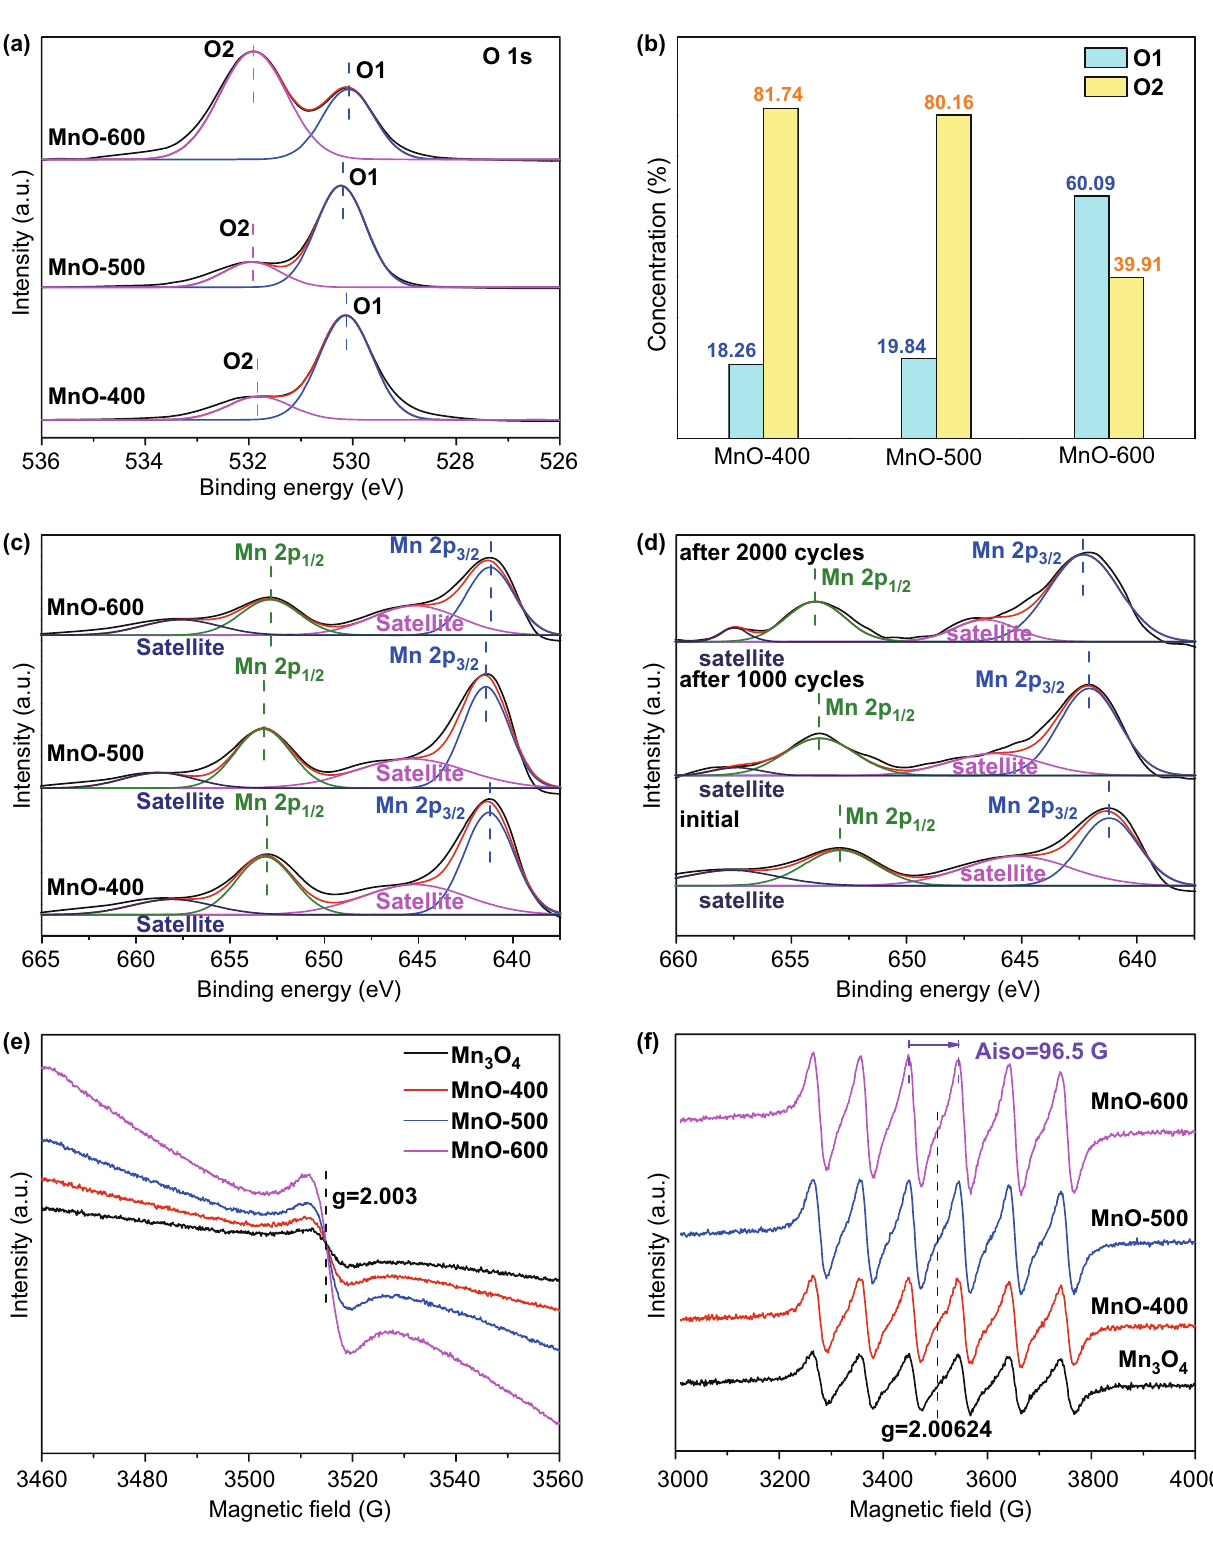
Fig. 3 a XPS O 1 s spectra among different MnO-T catalysts. b Contents of O1 and O2 peak for different MnO-T samples. c , d XPS Mn 2 p spectra of the starting MnO-T catalysts ( c) and MnO-600 of the initial and after 1000 and 2000 cycles of ORR tests ( d) . e , f ESR measurement results of Mn 3 O 4 and MnO-T samples for oxygen vacancies detections ( e) and Mn valence determinations (